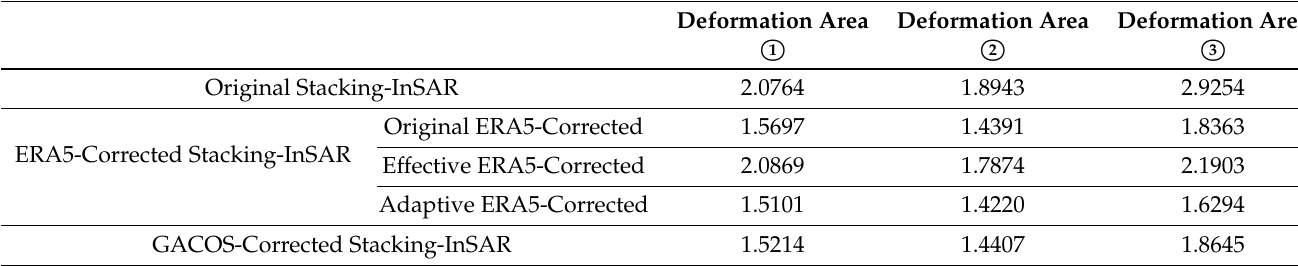
Table 2. Statistics on the mean values of standard deviations in the three main coal fire deforma- tion